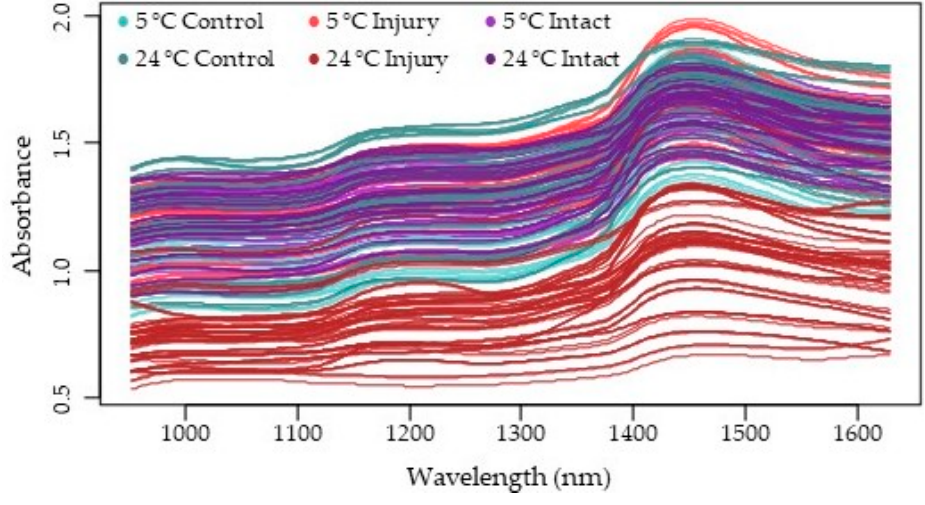
Figure 1. NIR spectra of control and infected plums samples from measurement day 8 ( N =